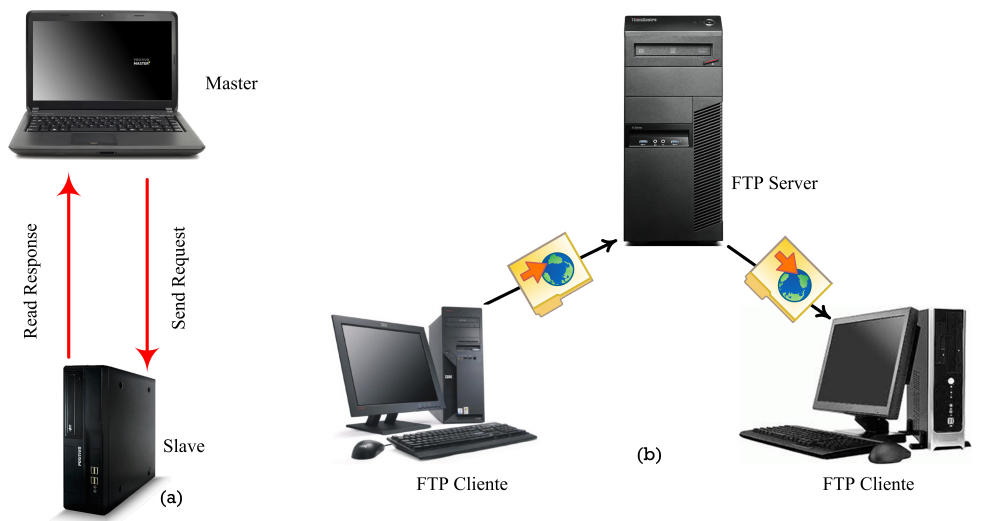
Figure 6. Schematic of the process involved in the Modbus protocols, including the ( a ) server and client (Master/Slave) communication, and ( b ) the process to request data using